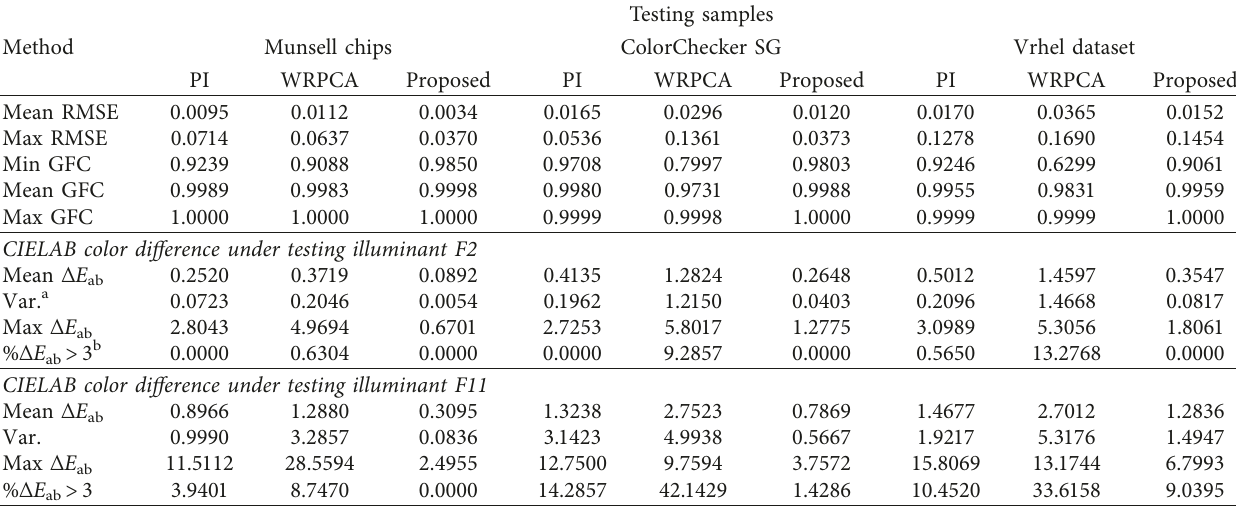
Table 3: Statistics of the comparison results among PI, WRPCA, and the proposed method.